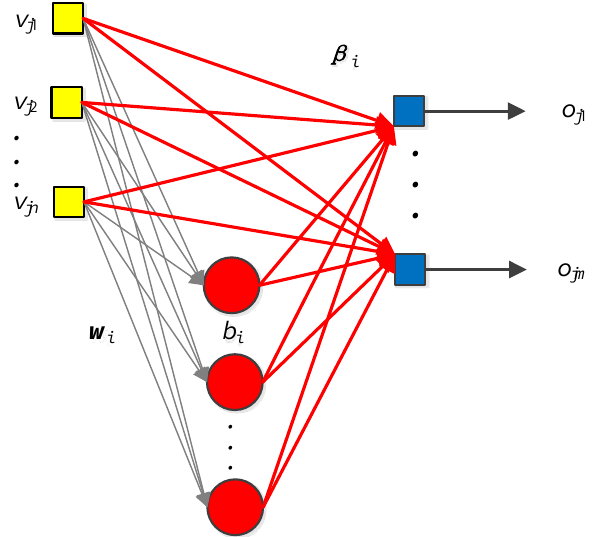
Figure 5. Structure of an RVFL.